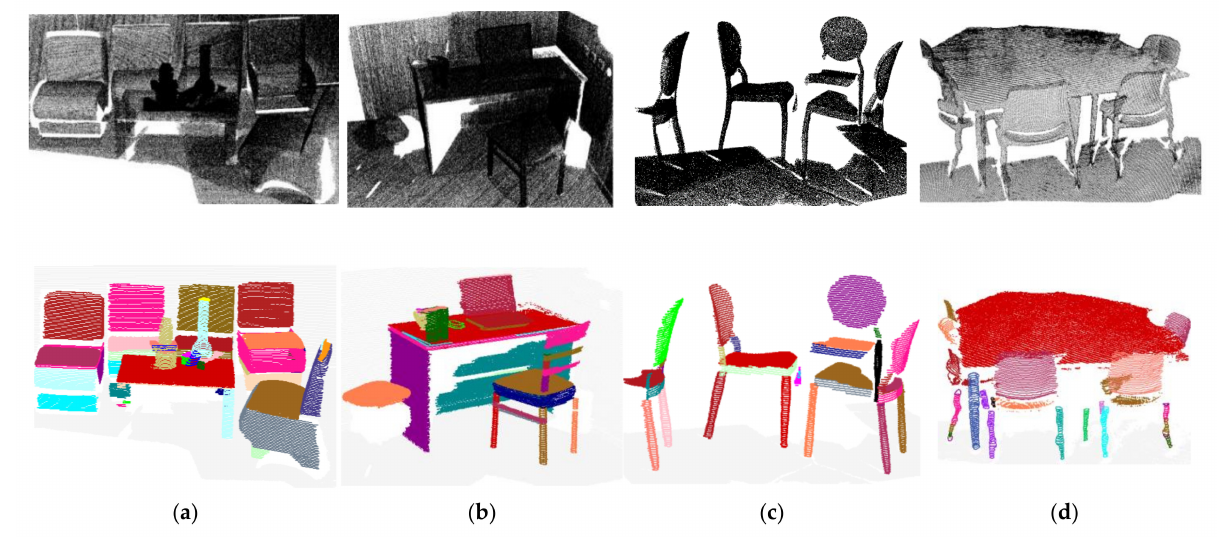
Figure 12. Experimental results of scenes of dataset [56], the first row is the input scene model, the second row is the indoor scene components detection result: ( a ) Living room; ( b ) Office; ( c ) Lounge; ( d ) Meeting